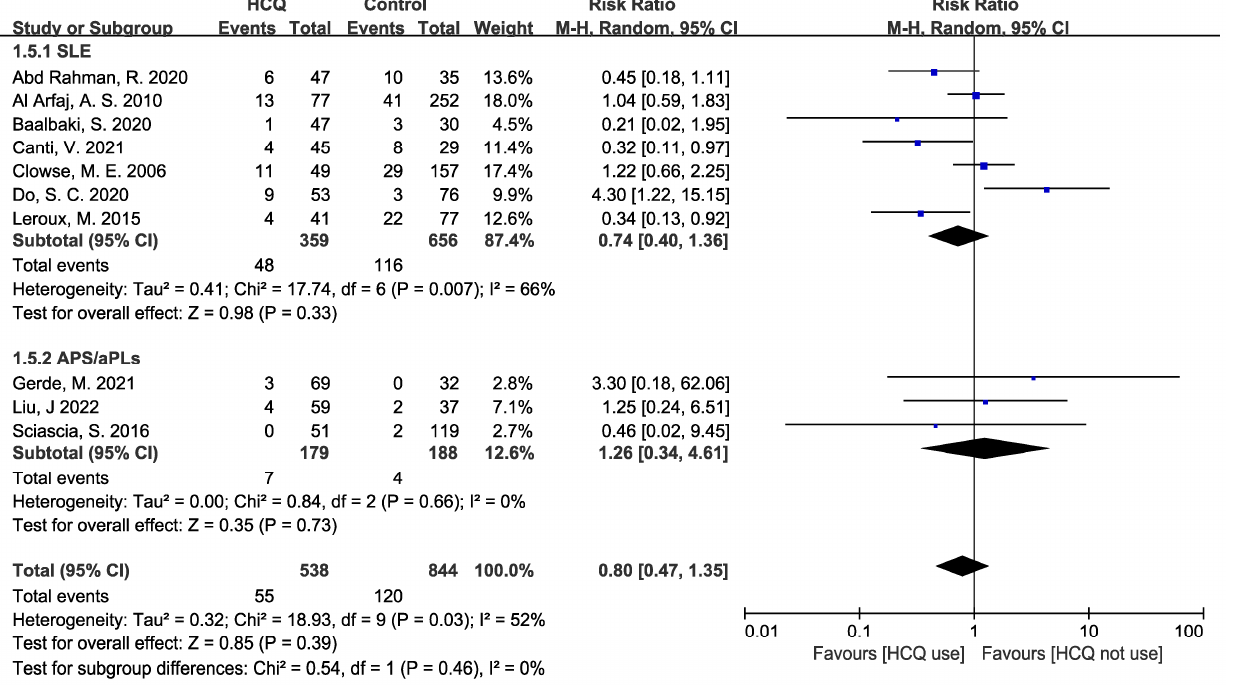
Figure 3. Forest plot for RR of IUGR. The pooled estimate of the RR of IUGR was determined for patients taking HCQ compared to those not taking HCQ. A subgroup analysis was conducted based on the study population.